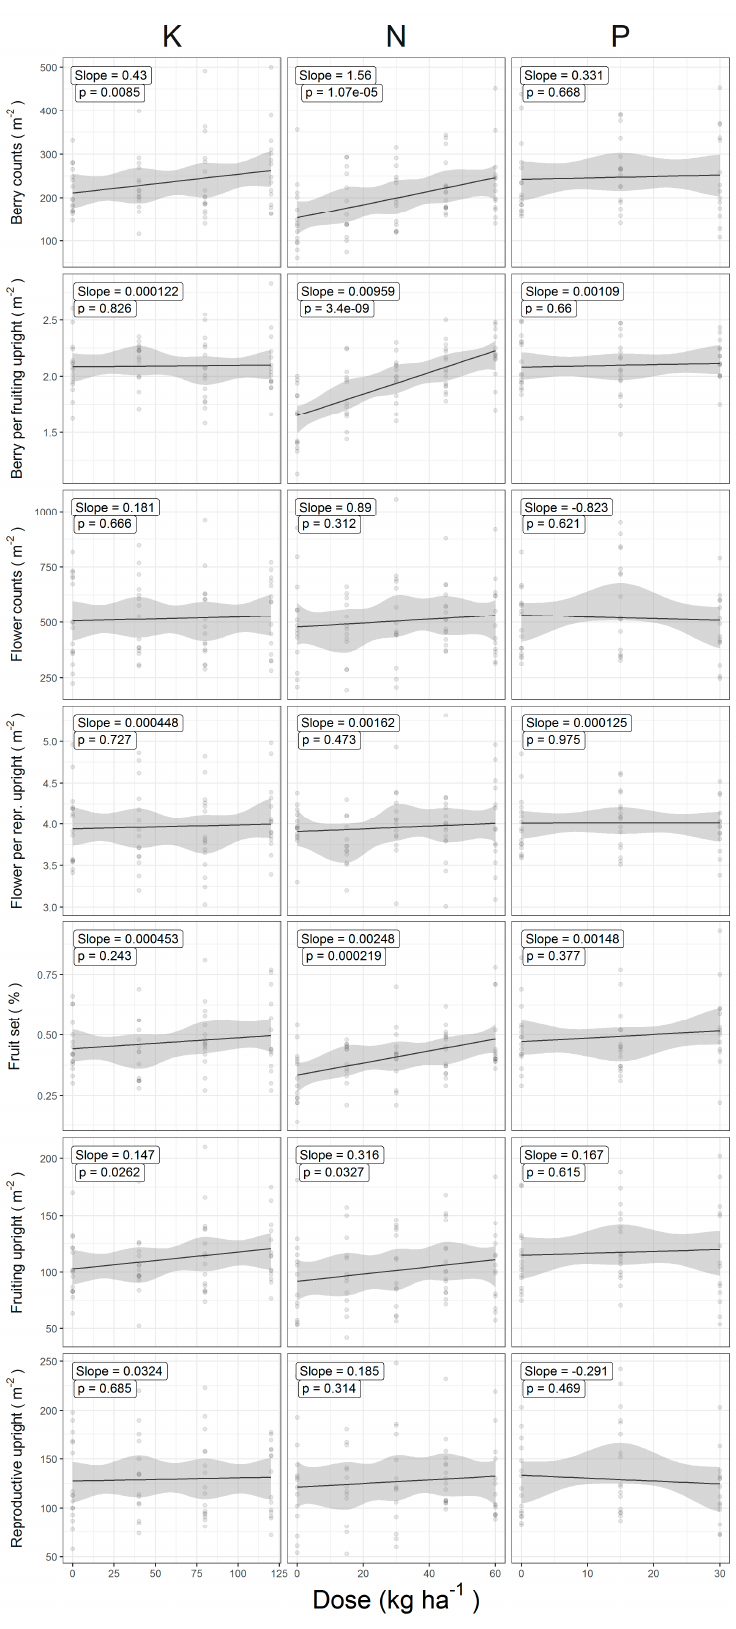
Figure 3. Response of cranberry yield components to added N, P, and K. The solid line represents the model fit with the slope and intercept of the line; the shaded area represents the 95% confidence